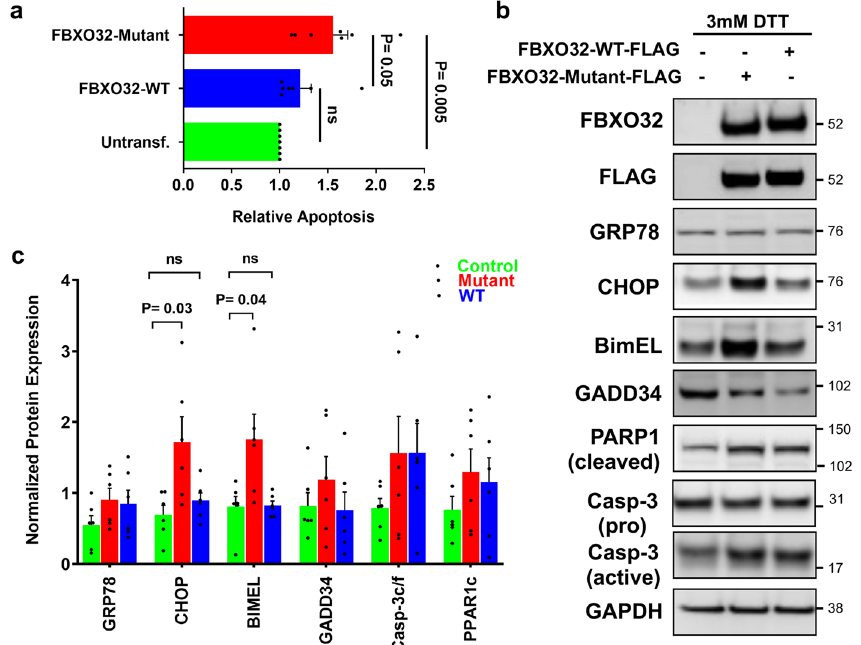
Fig. 6 Expression of mutant FBXO32 induces apoptosis and increases CHOP-mediated apoptosis in HEK293 cells. a Increased apoptosis in cells expressing mutant-FBXO32. HEK293 cells were transfected with FBXO32-WT or FBXO32 mutant and 30 h post transfection, DNA fragmentation indicative of apoptosis was measured using an ELISA assay. Results are expressed as relative values to untransfected cells. Data are expressed as average ± s.e.m. from n = 7 independent experiments. The statistical signi fi cance was determined by Student ’ s t -test. p values are shown; p < 0.05 was considered signi fi cant; ns non-signi fi cant. b Western blot analysis for CHOP-associated apoptosis pathway using protein extracts from untransfected cells, cells overexpressing mutant-FBXO32 or WT-FBXO32. 24 h post transfection, cells were treated with 3 mM DTT for additional 24 h before being harvested. Western blot analysis was performed using the indicated antibodies. c Quantitative analysis of ( b ); results are normalized against GAPDH and expressed as average ± s.e.m. from n = 5 independent experiments. p values are shown; p < 0.05 was considered signi fi cant; ns non-signi fi